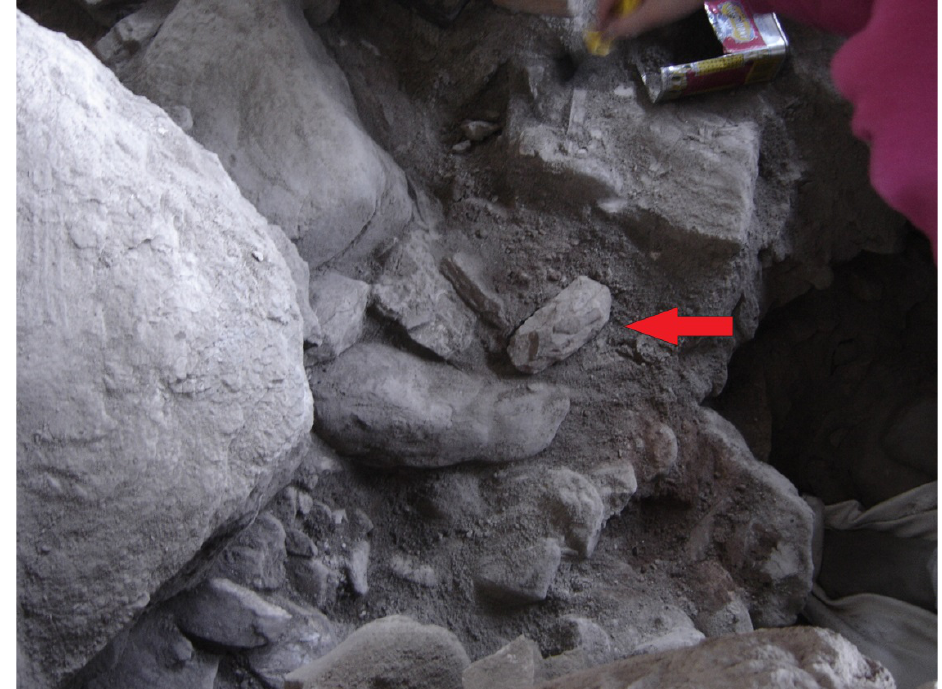
Figure 5. Location of the artifact. Photo by Astolfo